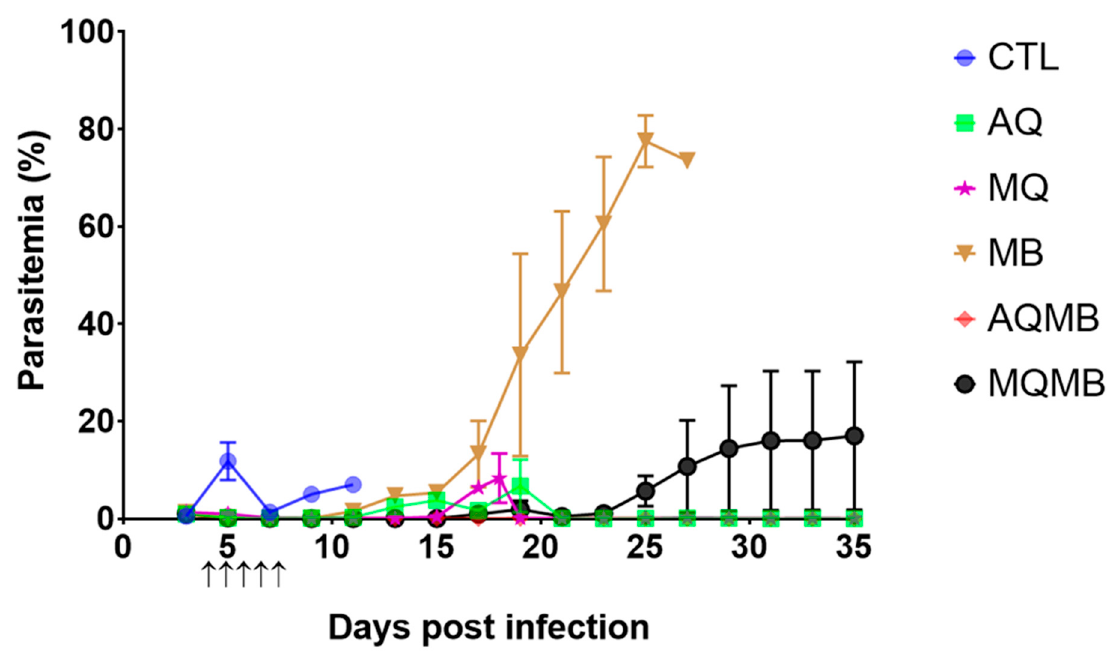
Figure 3. Parasitemia evolution for all the therapeutic groups. In blue, control (CTL) with saline solution for five days. In green, AQ 5 mg/kg for three days. In purple, MQ with 5 mg/kg for three days. In brown, MB with 10 mg/kg for five days. In red, MB with 10 mg/kg for five days associated with AQ 5 mg/kg for three days (AQMB). In black, MB with 10 mg/kg for five days associated with MQ 5 mg/kg for three days (MQMB). Black arrows indicate days of treatment.